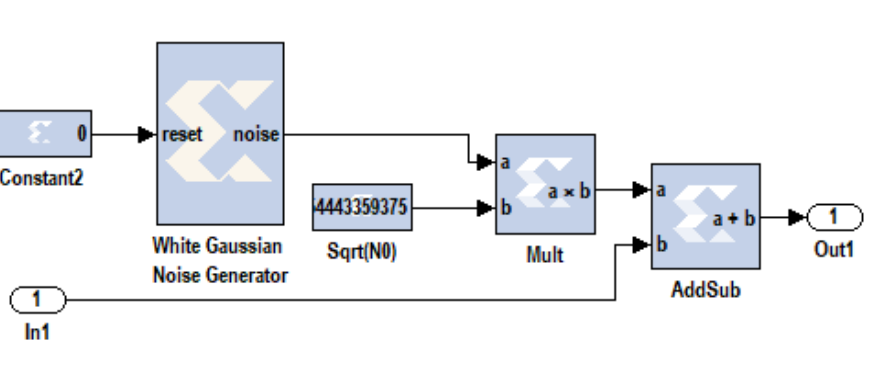
Fig. 7. The Xilinx SG block diagram of AWAGN